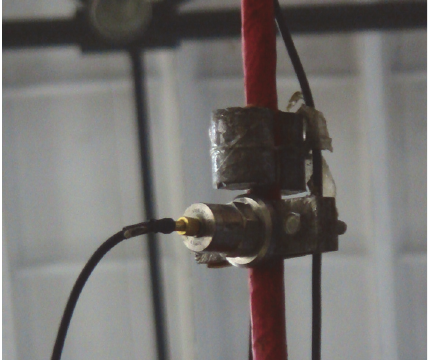
Figure 7: Power amplifier.